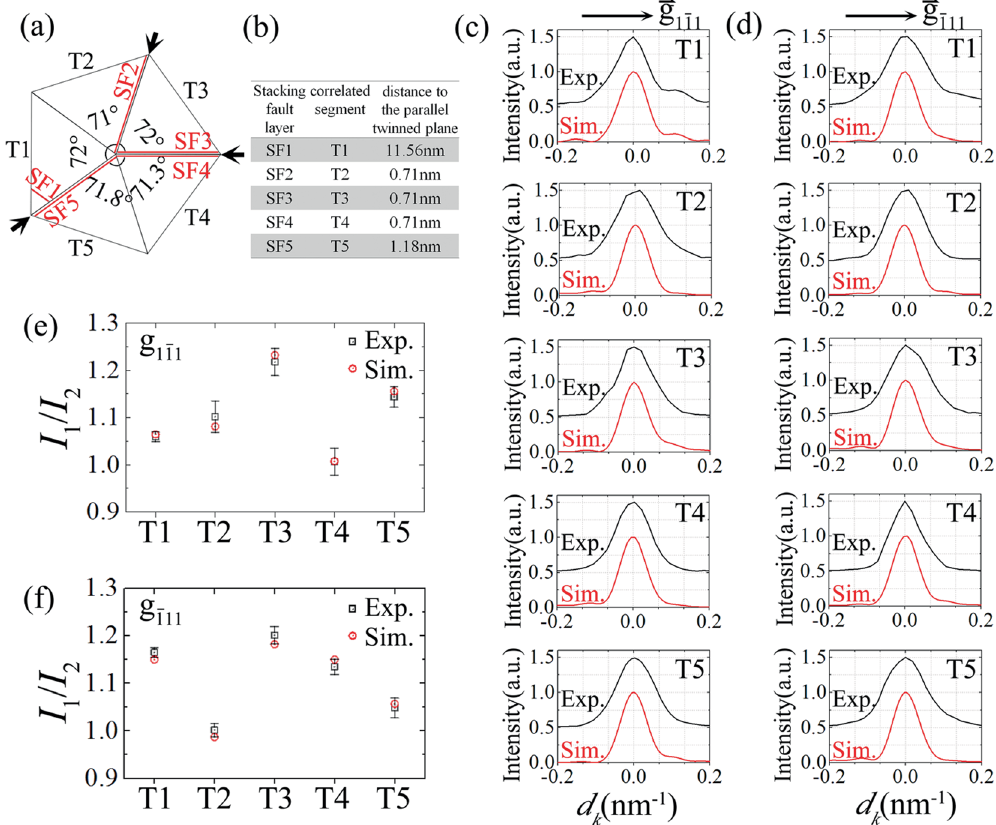
Figure 6. The cross-section structure model of the Ag FTNW in this study and the corresponding kinematical electron diffraction simulation. ( a ) The schematic structural model for the studied Ag FTNW. The model indicates that the inhomogeneous lattice distortion induces different angular increases of five single crystallites. Near the twinning boundaries indicated by black arrows, five stacking fault layers (SF1~SF5) are incorporated and responsible for the partial compensation of the angular misfit. The distances of five stacking fault layers to their parallel twinned plane are displayed in ( b ). According to this structural model, the kinematic electron diffraction simulation results (Sim.) for the intensity profiles of five (331) reflections along the characteristic   directions parallel to and , are demonstrated in ( c ) and ( d ), respectively. In ( c ) and ( d ), the simulation g g 111 111 intensity profiles (Sim.) are compared with their experimental counterpart (Exp.). ( e ) and ( f ) illustrate the   calculated integrated intensity ratios ( I 2 / I 1 as defined in Fig. 5) of the and line-profiles, respectively, for g g 111 111 the five segments (T1~T5) shown in ( a ), and compare them with the corresponding experimental